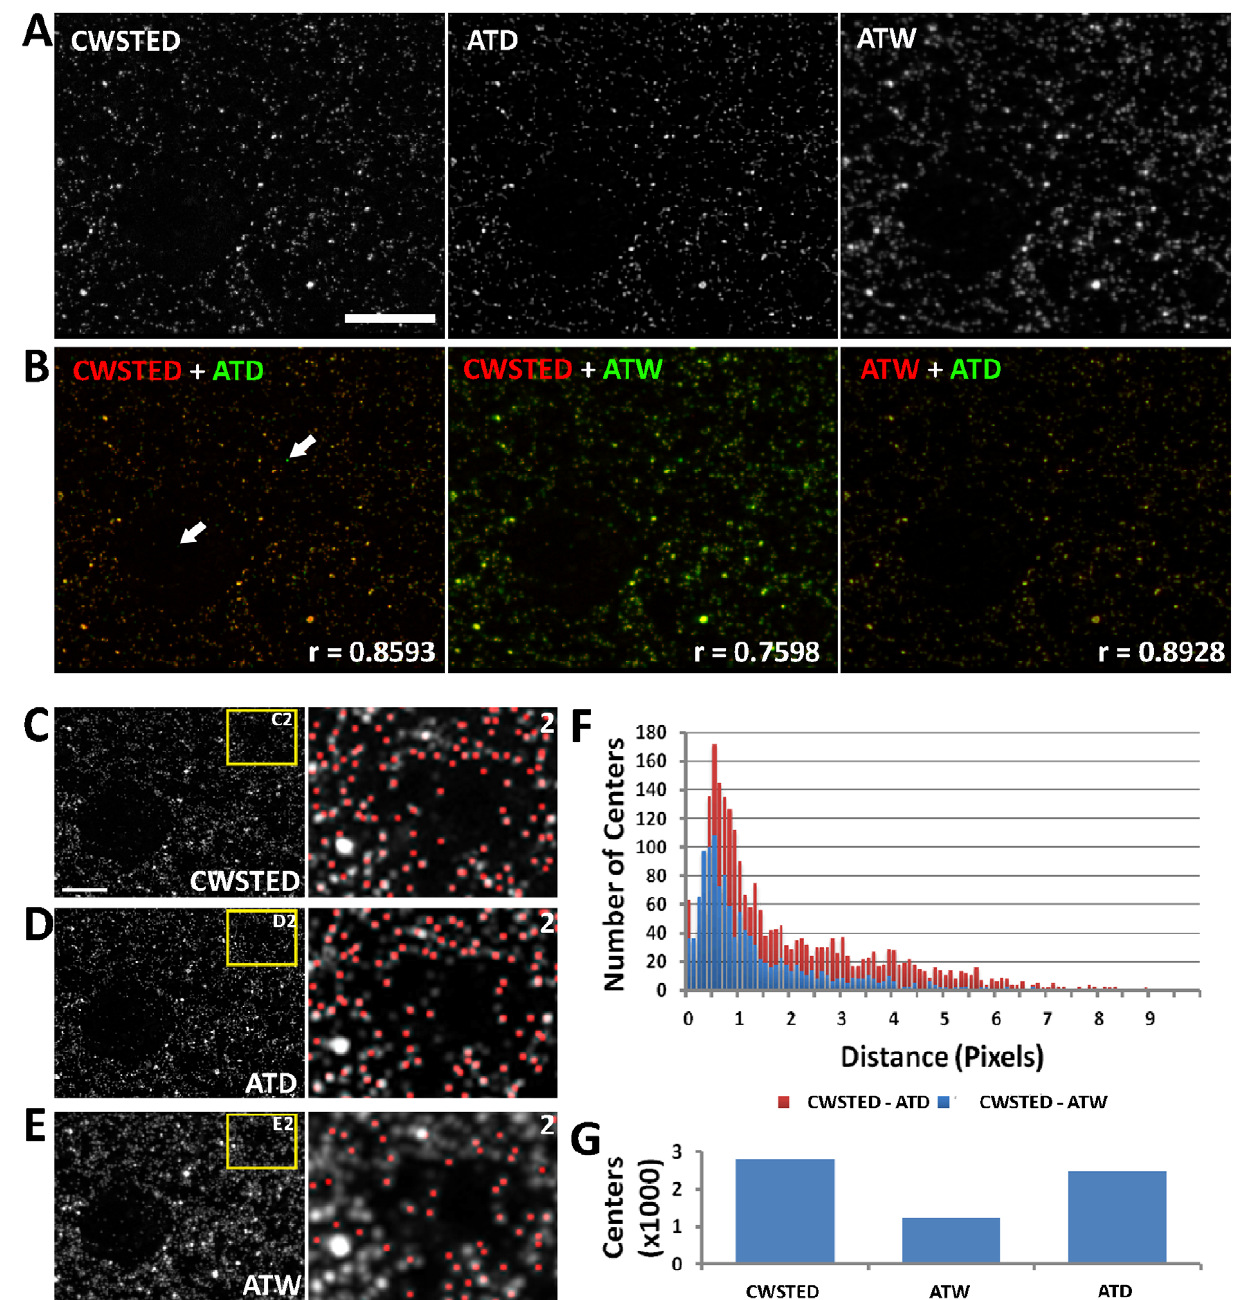
Figure 6. Comparison of Synapsin puncta imaged using CWSTED versus deconvolution. (A) Image of a single thin section imaged in CWSTED, ATW and ATD image. (B) Overlay of CWSTED (red) to ATW (green), CWSTED (red) to ATD (green) and ATW (red) to ATD (green). Note the high correspondence between the images, especially that of the CWSTED and ATD. The arrows in B point to apparent points in the ATD image (green) that is not in the CWSTED image (red). These few discrepancies are most likely due to the loss of primary antibody in a viscous mounting media overnight, because the CWSTED images were taken the day after the AT images, mostly because of the tendency of the CWSTED to bleach the sample during imaging. R value is the calculated Pearson’s correlation coefficient between the two images. (C–E) Max projection of identical tissue volumes (ten 70 nm sections) imaged in CWSTED, ATW and ATD. Note that the CWSTED images were acquired using a 100 6 objective with 50 nm pixels whereas the AT images were acquired using a 63 6 objective with 100 nm pixels, thus the images were scaled and aligned to maintain the correct aspect ratios. Scale Bar=5 um. (F) A distance histogram of centers of mass calculated from the CWSTED volume as compared to the ATW volume or the ATD volume. (G) A bar graph representing the total number of object centers found in the CWSTED volume, the ATW volume and the ATD volume.